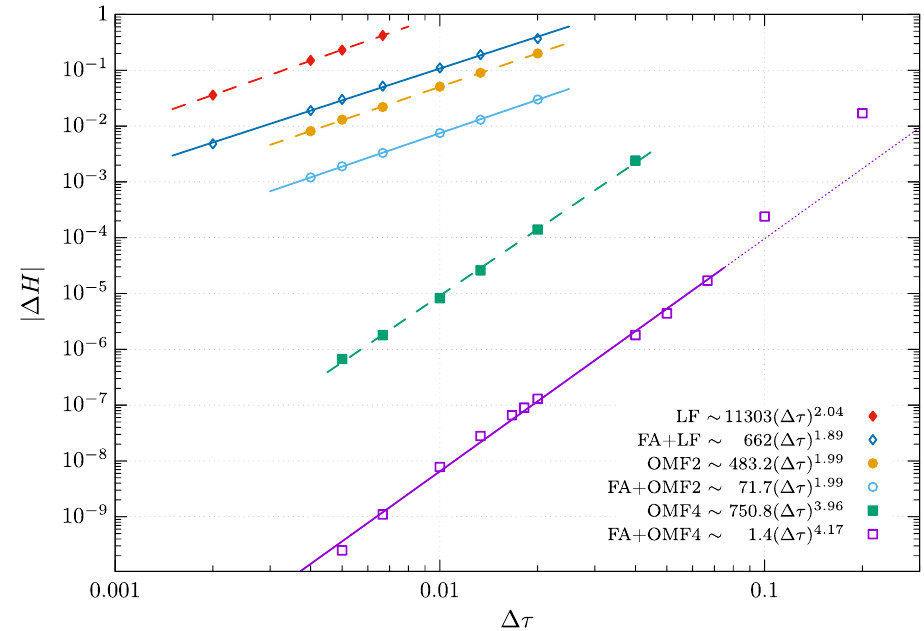
Fig. 4 Violations of MD Hamiltonian conservation (cid:9) H as a function of the MD integration step-size (cid:9)τ , for all available integrators (LF, OMF2, OMF4), with and without Fourier Acceleration (FA). The lines represent the fit